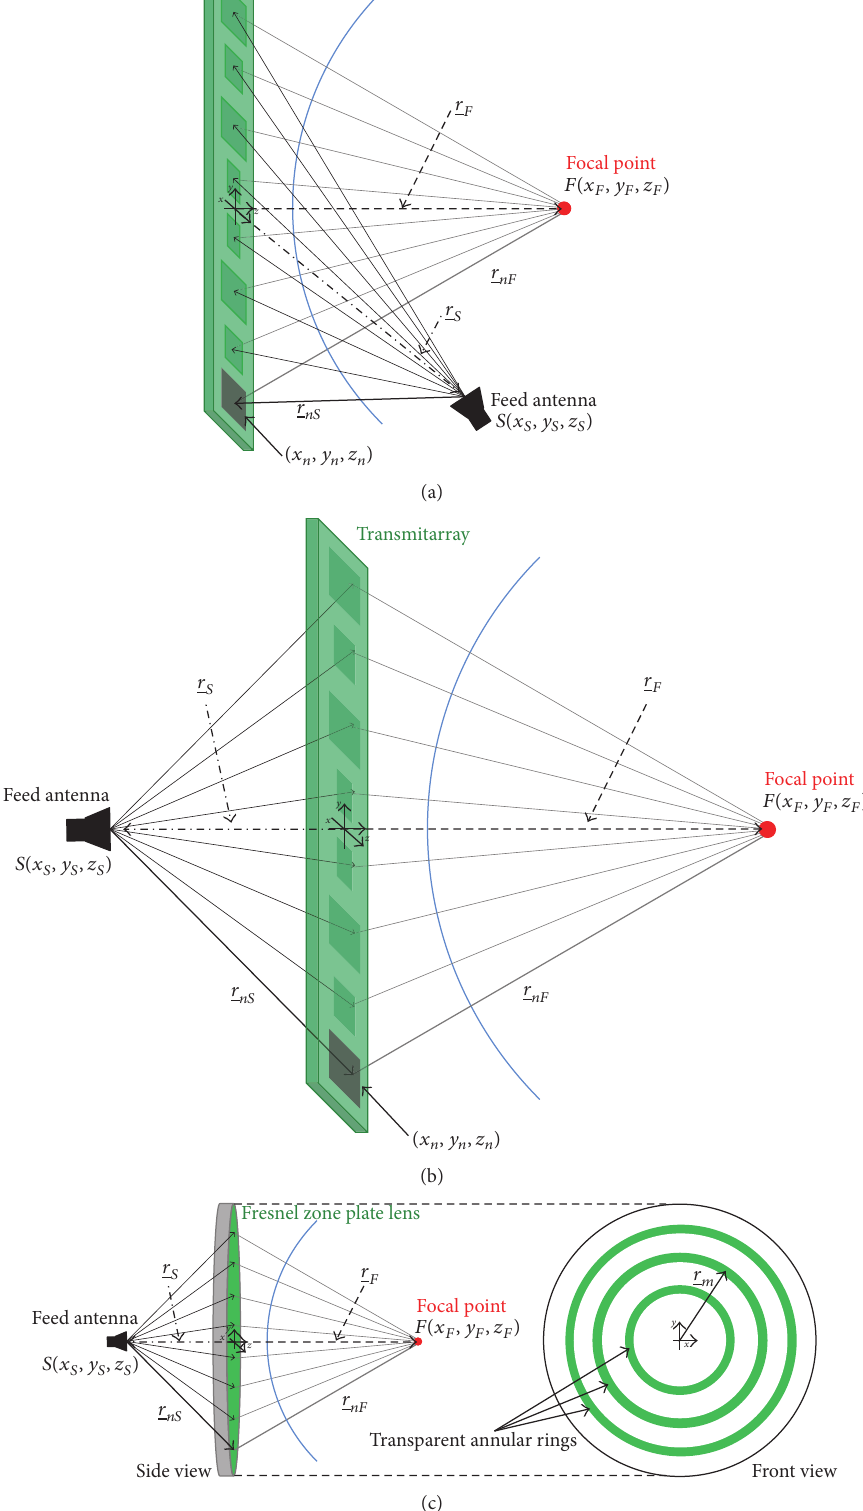
Figure 4: Basic geometrical configurations of different NFF planar lens antennas: (a) reflectarray, (b) transmitarray, and (c) Fresnel zone plate lens. The spherical wave radiated by the feed at 𝑆(𝑥 𝑆 , 𝑦 𝑆 ,𝑧 𝑆 ) interacts with the antenna layer to excite a field that is focused at 𝐹(𝑥 𝐹 ,𝑦 𝐹 ,𝑧 𝐹 )